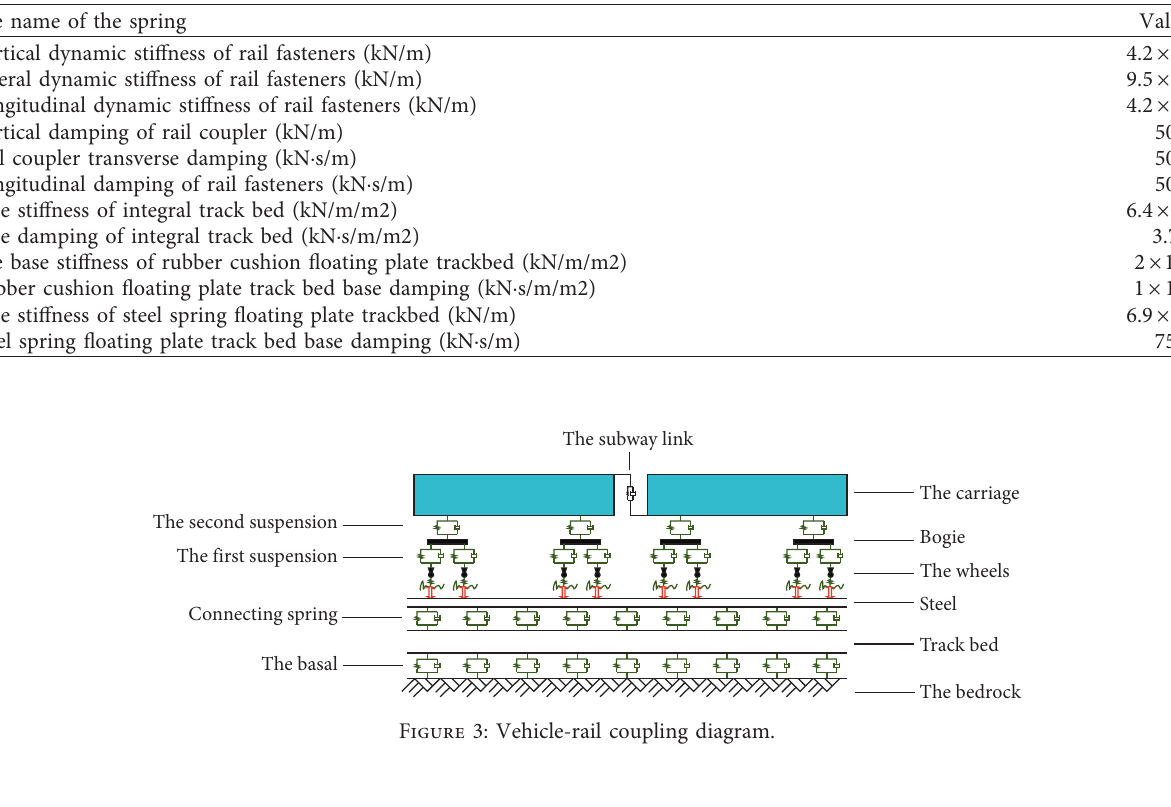
Table 6: Parameters of the spring of the